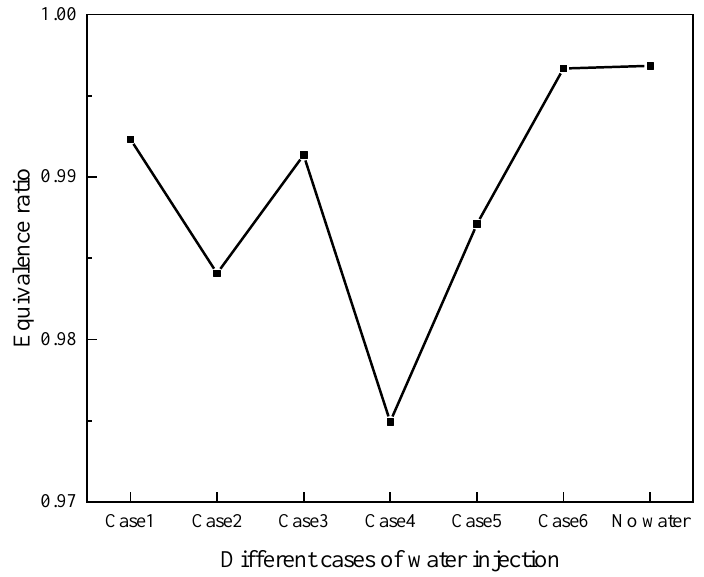
Figure 11. Mean equivalence ratio in cylinder at ignition time in different water injection cases (CR = 10.3, ignition time = − 14 degCA).